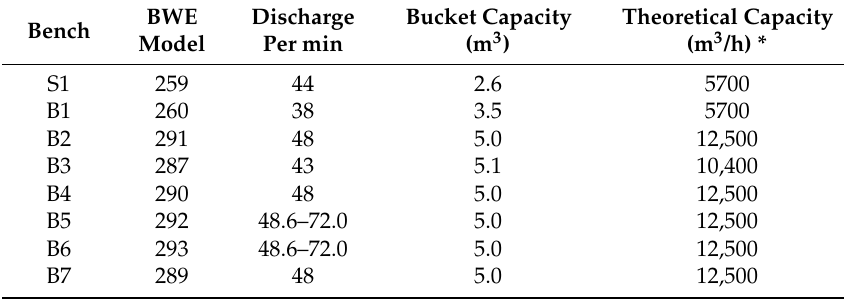
Figure 4. Schematic overview of the production system of the Hambach mine. Table 1 . Technical specification of BWEs.